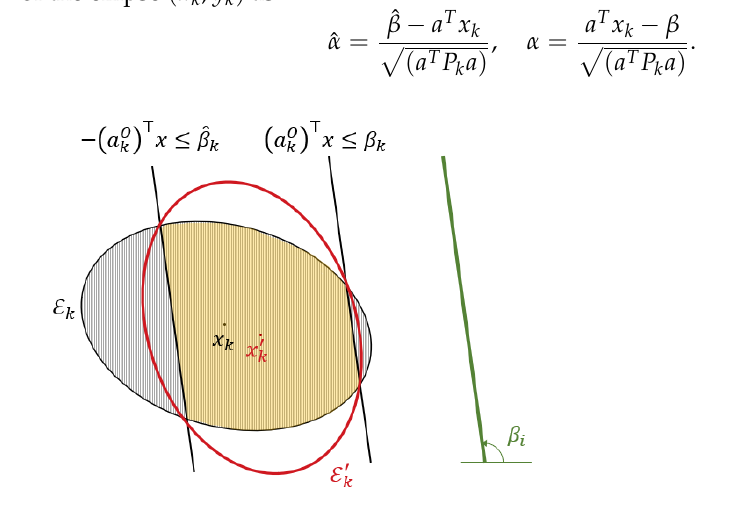
, using the parallel-cuts k